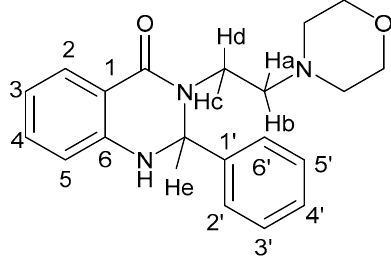
Figure 4. Structure of 4a.